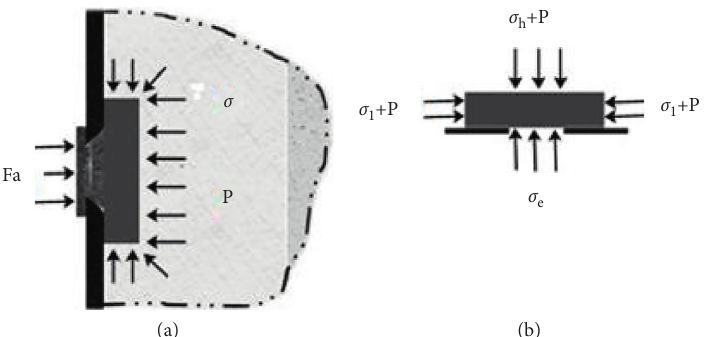
Figure 4: Bearing model of yellow mud barrier layer.